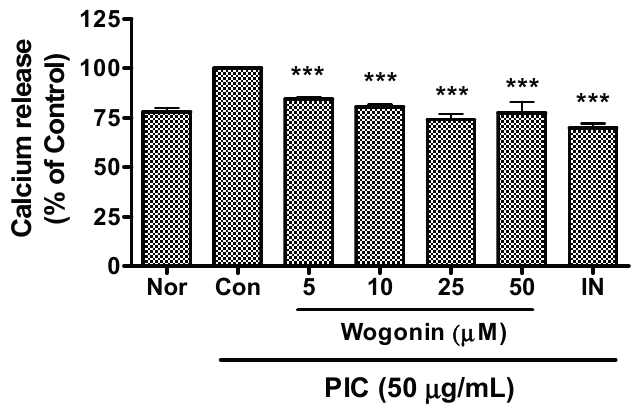
Figure 5. Effects of wogonin on calcium release in dsRNA-induced RAW 264.7 mouse macrophages. After 24 h treatment, calcium release was measured with Fluo-4 calcium assay. Normal group (Nor) was treated with media only. Control group (Con) was treated with the synthetic analog of dsRNA (PIC, 50 µg/mL of polyinosinic-polycytidylic acid alone. IN denotes indomethacin (0.5 µM). Values are the mean ± SD of three independent experiments. *** P < 0.001 vs. Con.